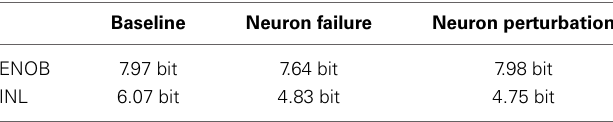
Baseline hardware characteristic, neurons reduced to 128. ENOB and INL represent the average of 10 runs with different perturbations/failures.